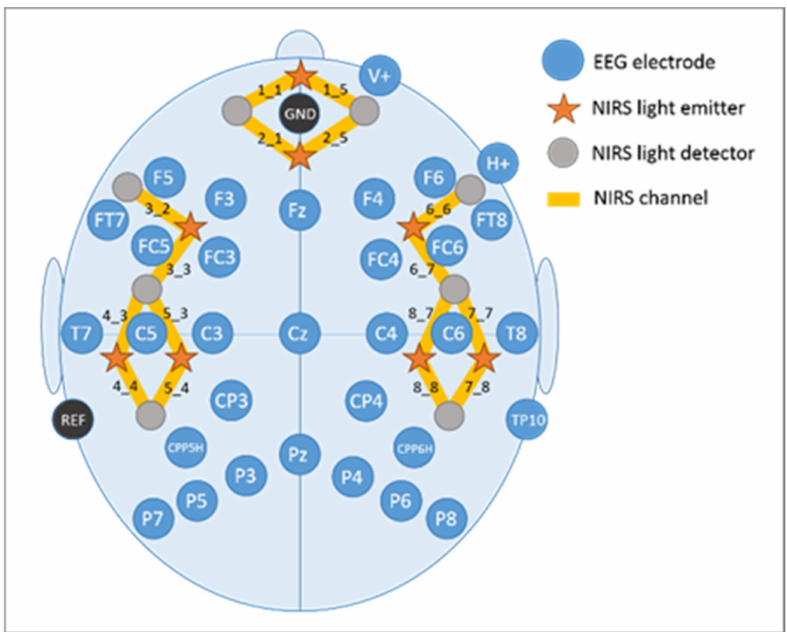
Figure 6. EEG electrode and fNIRS optode